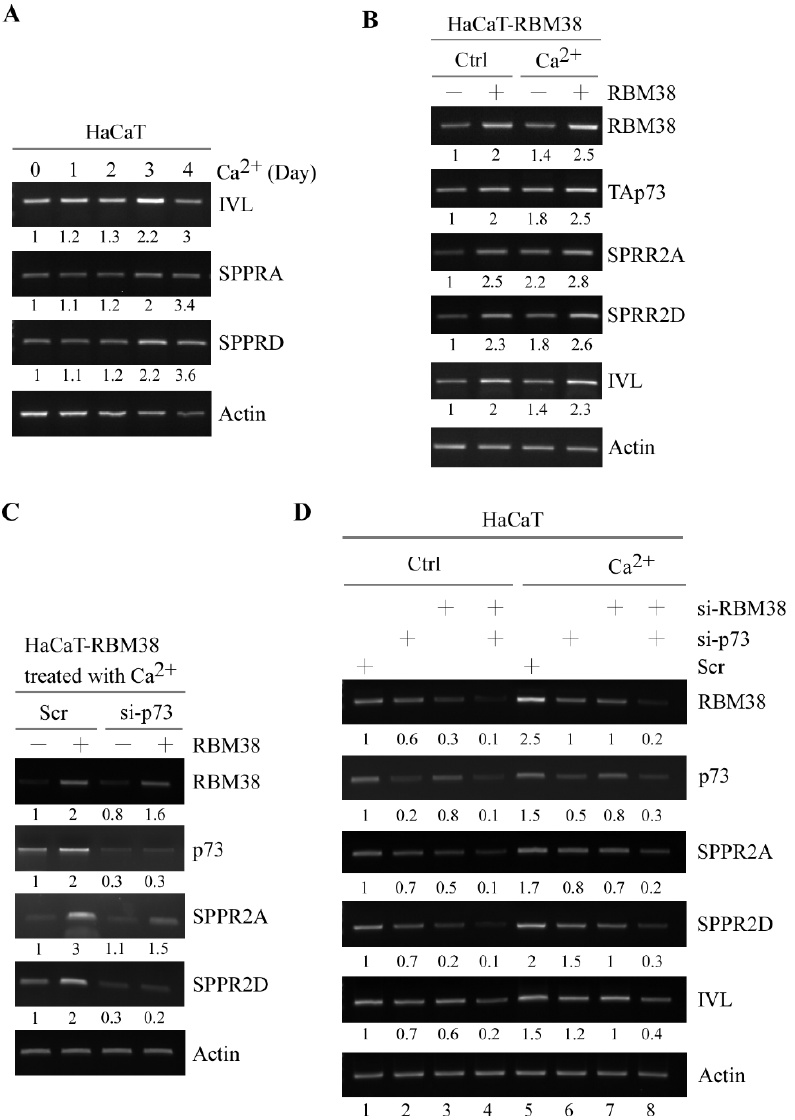
Figure 3. SPRR2A and SPRR2D are induced by p73 and RBM38 to promote keratinocyte differentia- tion. ( A ) HaCaT cells were treated with Ca 2+ from 0–4 days and the levels of IVL, SPRR2A, SPRR2D and actin transcripts were examined by RT-PCR analysis. ( B ) HaCaT cells was uninduced or induced to express RBM38 for 12 hours, followed by treatment with or without Ca 2+ for 3 days. The levels of RBM38, p73, IVL, SPRR2A, SPRR2D and actin transcripts were examined by RT-PCR analysis. ( C ) HaCaT cells uninduced or induced to express RBM38 were transiently transfected with a control or p73 siRNA for 24 h, followed by Ca 2+ for 3 days. The levels of RBM38, p73, SPRR2A, SPRR2D and actin transcripts were examined by RT-PCR analysis. ( D ) HaCaT cells were transiently transfected with a control siRNA or siRNA against either p73 or RBM38 or both for 24 hours, followed with or without Ca 2+ for 3 days. The levels of RBM38, p73, SPRR2A, SPRR2D, IVL and actin transcripts were examined by RT-PCR